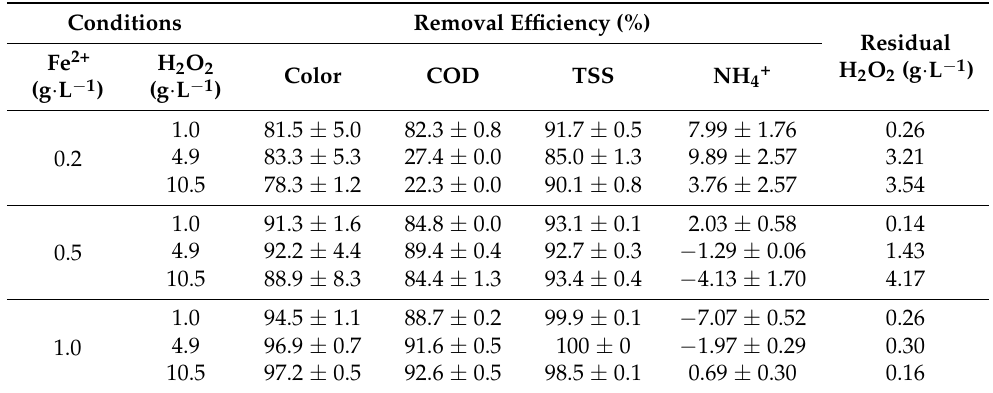
Table 2. Removal efficiencies (%) after photo-Fenton (pH 3 and 120 min) in the tested conditions (Fe 2+ and H 2 O 2 concentrations) for color (given by absorbance measured at 540 nm), ammonia (NH 4+ ), chemical oxygen demand (COD), and total suspended solids (TSS). The residual H 2 O 2 present at the end of each run is also shown.